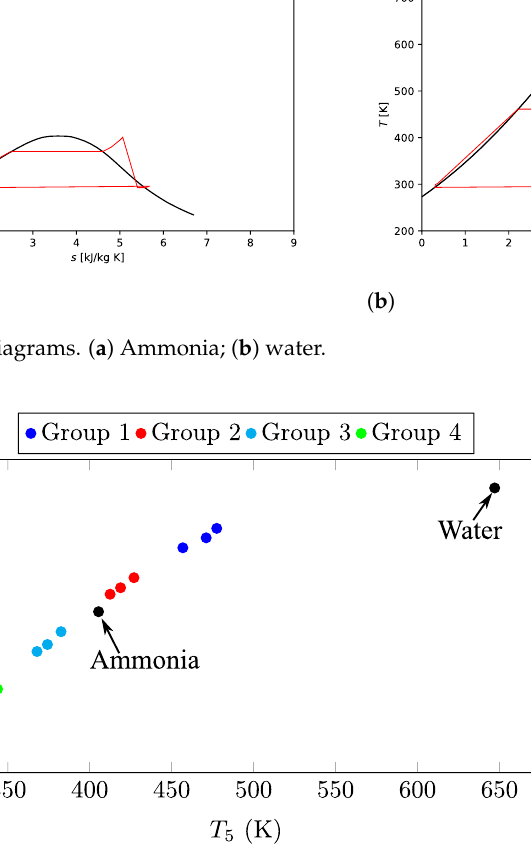
Figure 9. Maximum performance depending on the output super-heater